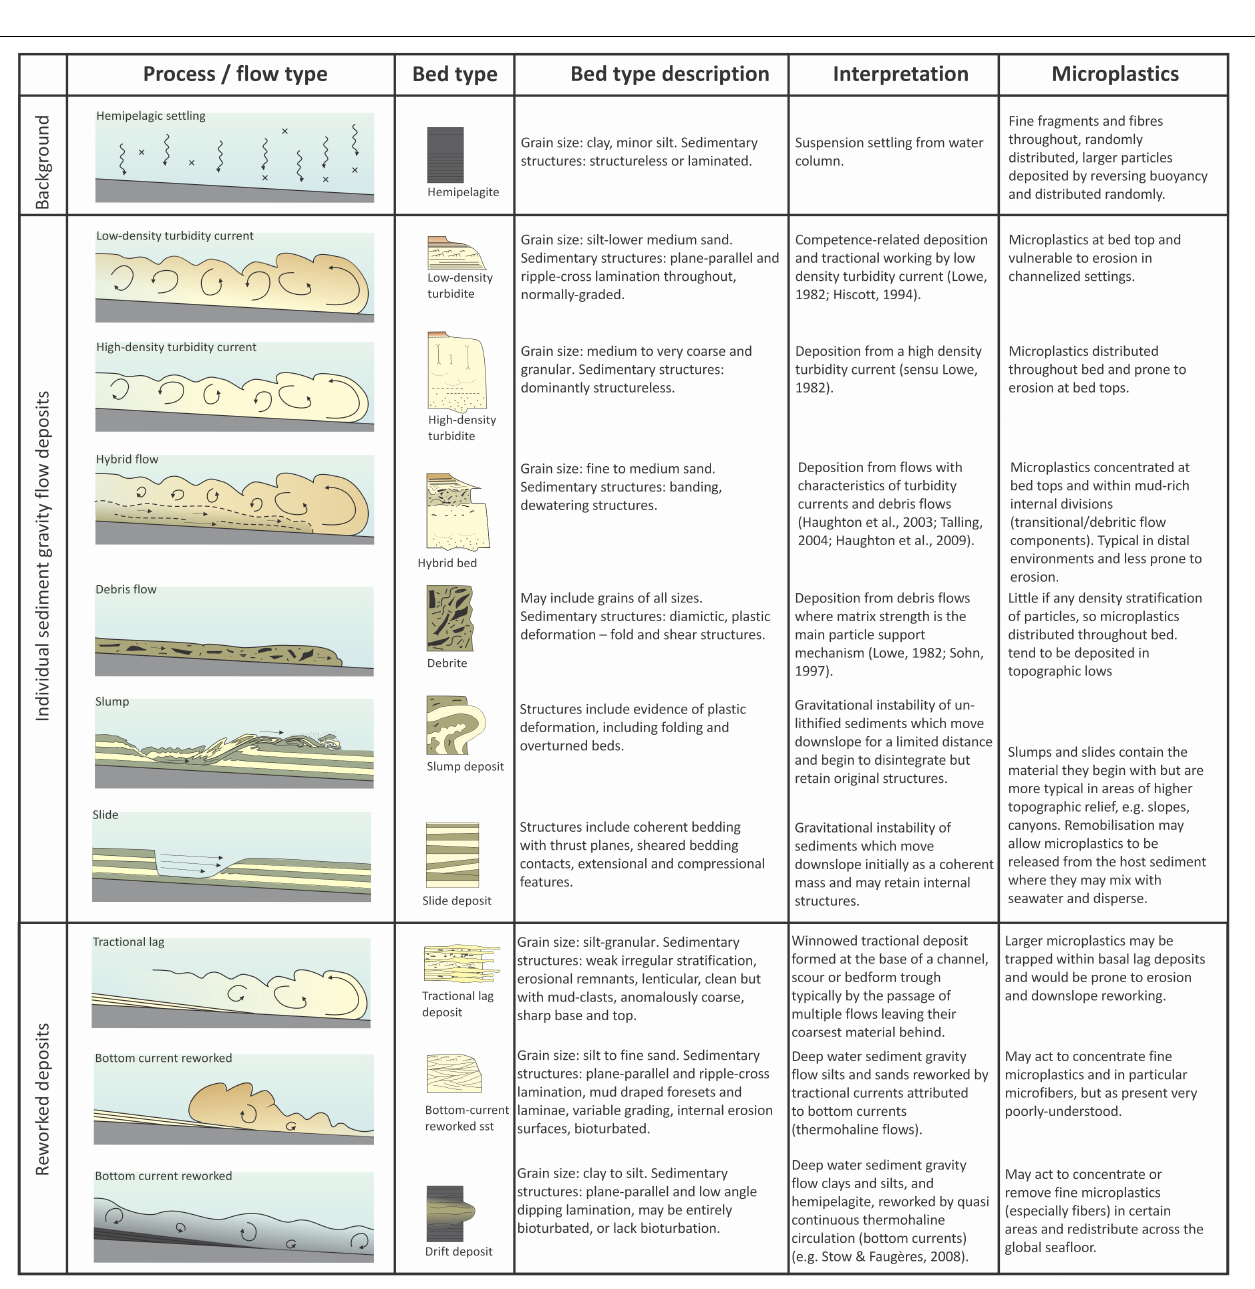
FIGURE 10 | Range of sediment gravity flow types, their deposits, and the anticipated distribution of microplastics. This is important as specific benthic ecosystems develop in depositional sites prone to particular sediment gravity flow types; the deposit type then has a bearing on the likelihood of remobilization of microplastic and its availability for ingestion by benthic